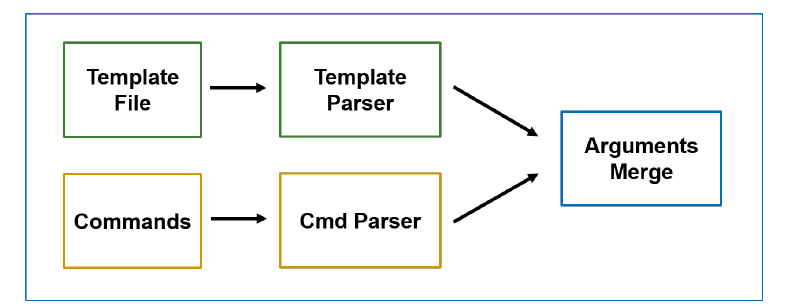
Figure 3: Processing with the Template Function